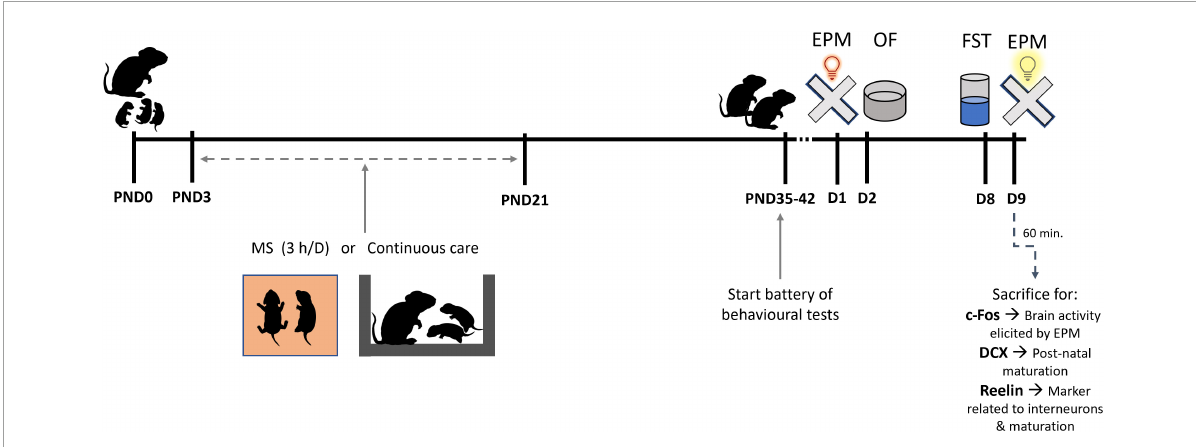
FIGURE1 Diagram of the experimental design. In the litters assigned to maternal separation (MS), pups were separated from the dam for 3 h per day between postnatal days (PND) 3 and 21. After MS, pups were returned to their home cage. Behavioural testing started at 5 weeks of age with at least 24 h gap between tests consisting on: elevated plus maze (EPM), open field (OF), forced swim test (FST). The day after FST, animals were subjected to a new EPM but in bright light (more aversive) and 1 h after this test animals were transcardially perfused to obtain brain samples for histological